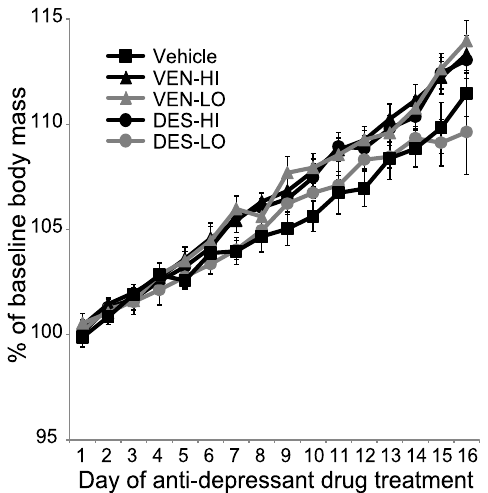
Figure 1. Anti-depressants increased body weight gain in the second week of treatment. Daily weights taken throughout the 16 days of antidepressant treatment confirmed normal growth among vehicle (n=5) and DES-LO (n=5) treatment groups and reveal that the low (n= 5) and high (n=6) doses of venlafaxine or the high desvenlafaxine dose (n=5) promoted weight gain in male rats beyond that expected of normal growth. Specifically, greater % changes from baseline body masses were detected during the second week of antidepressant drug treatment in VEN-HI rats ( p values , 0.05 for Days 10, 12, 14 and 15), VEN-LO rats ( p values , 0.05 for Days 9, 10, 12, 15 and 16) and DES-HI rats ( p values , 0.05 for Days 10, 11, 12, 15 and 16) relative to Vehicle-treated rats. Data are expressed as mean 6